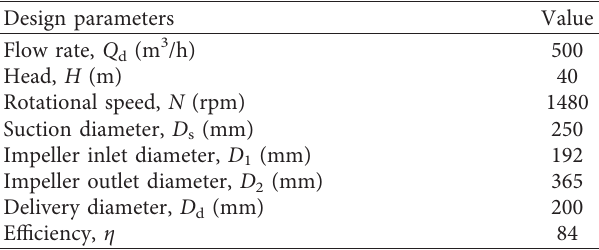
Figure 1: Computational model for model pump. (a) Complete model, (b) suction, and (c) impeller. Table 1: Design specifications of model